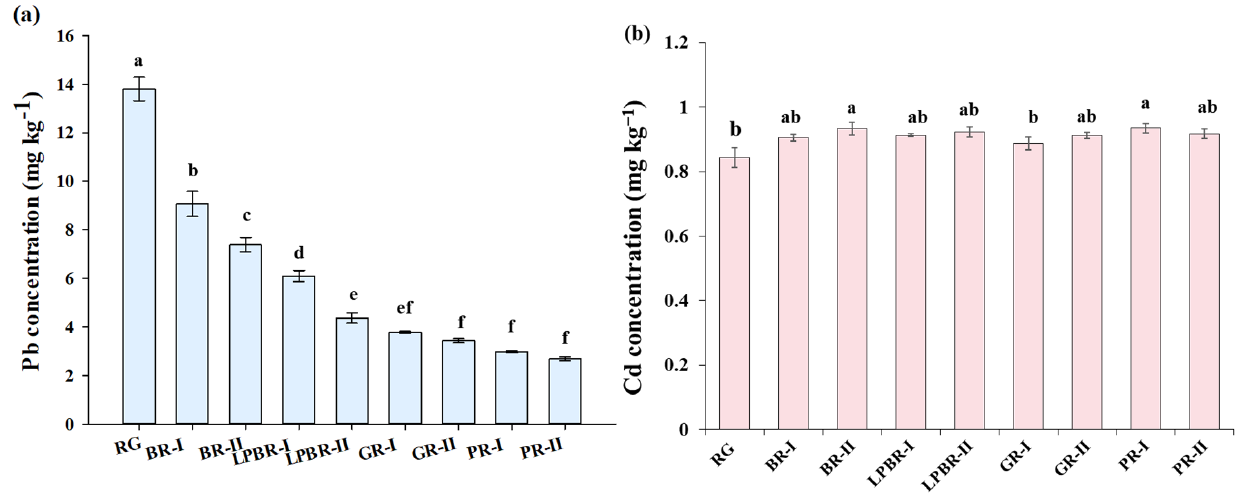
Figure 2. Concentrations of Pb ( a ) and Cd ( b ) in rice with four types of polishing degrees. RG, rice grain; BR, brown rice; LPBR, lightly processed brown rice; GR, germinated rice; PR, polished rice. I and II indicate the two parallel processing in each polishing degree. Different lowercase letters indicate that the concentrations of lead and cadmium in rice with different polishing degrees differ significantly at p < 0.05.